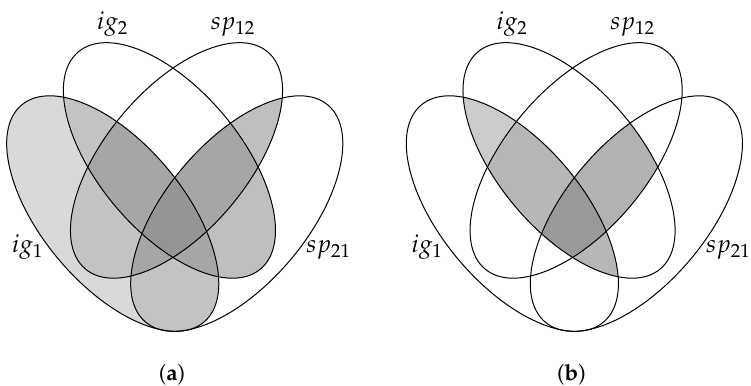
. ( b ) Venn diagram for minimum set 1